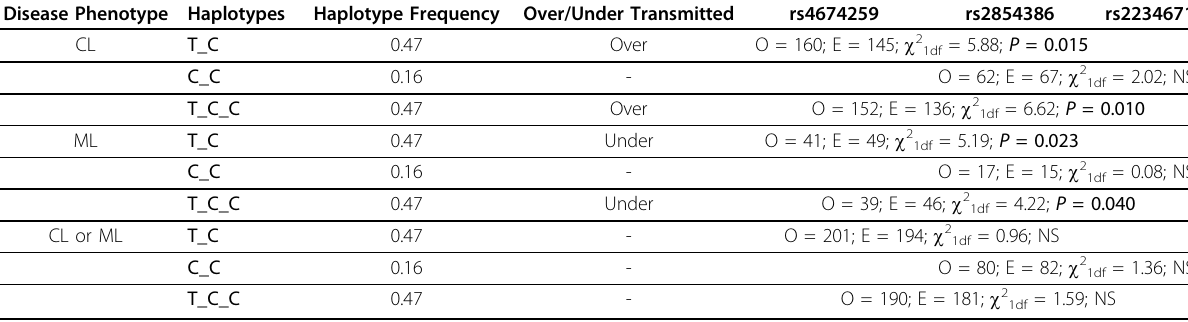
Table 4 Haplotype analysis of family data Disease Phenotype Haplotypes Haplotype Frequency Over/Under Transmitted rs4674259